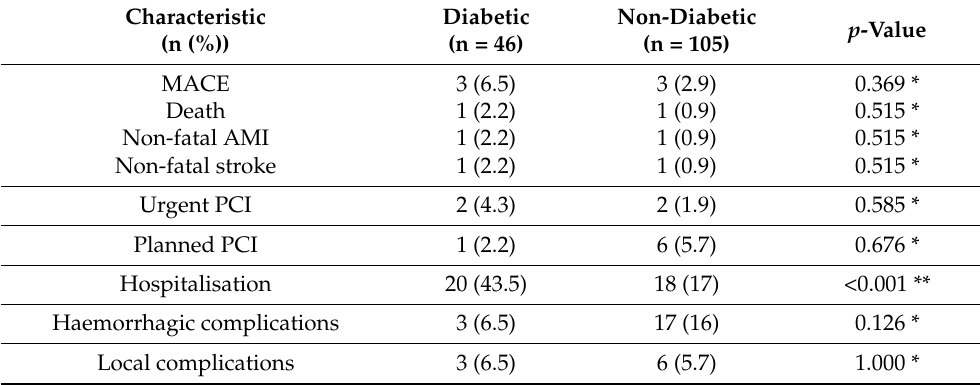
Table 5. Diabetes mellitus, risk of MACE and other adverse events.